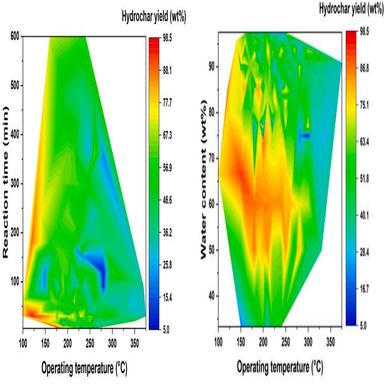
Effect of operating parameters including temperature, reaction time, and water content on hydrochar yield during biomass HTC process.